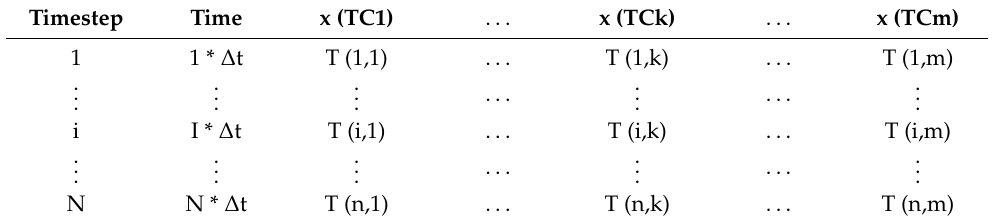
Table 2. The temperature as a function of time and the position in the sample.